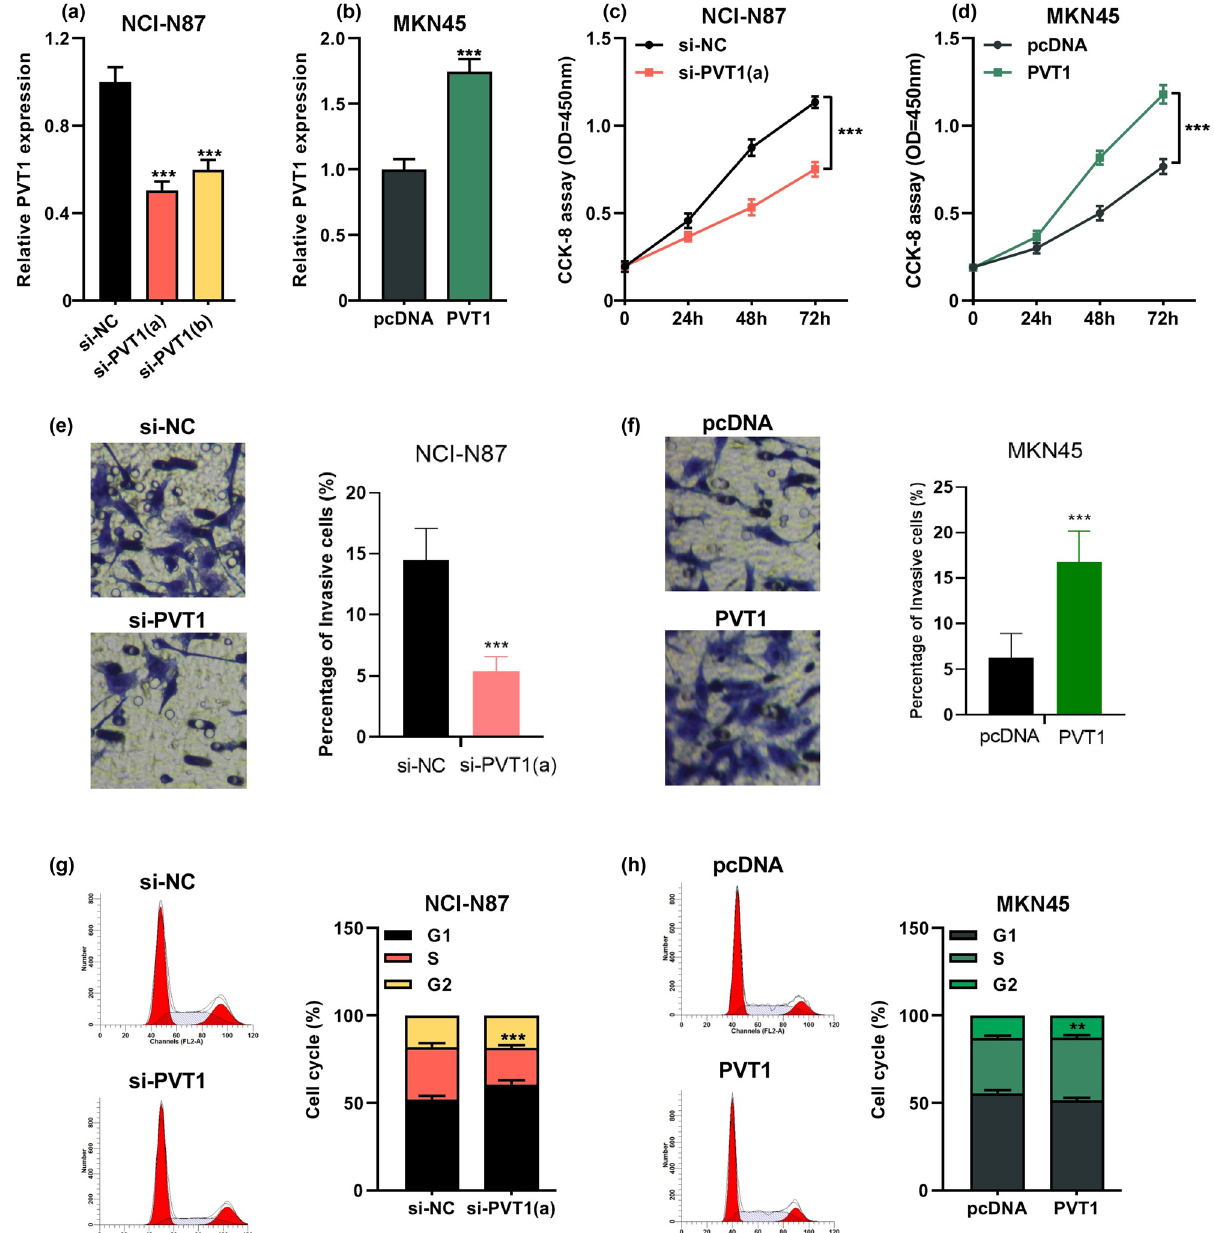
Figure 2: PVT1 knockdown inhibited the proliferation and invasion of GC cells, NCI - N87 cells were transfected with small interference RNA ( siRNA ) targeting PVT1 ( si - PVT1 ) or negative control ( si - NC ) . MKN45 cells were transfected with pcDNA3.1 empty vector ( pcDNA ) or pcDNA - PVT1 ( PVT1 ) . ( a and b ) qRT - PCR was used to detect the transfection e ffi ciency at 48 h after transfection. ( c and d ) CCK - 8 assay was